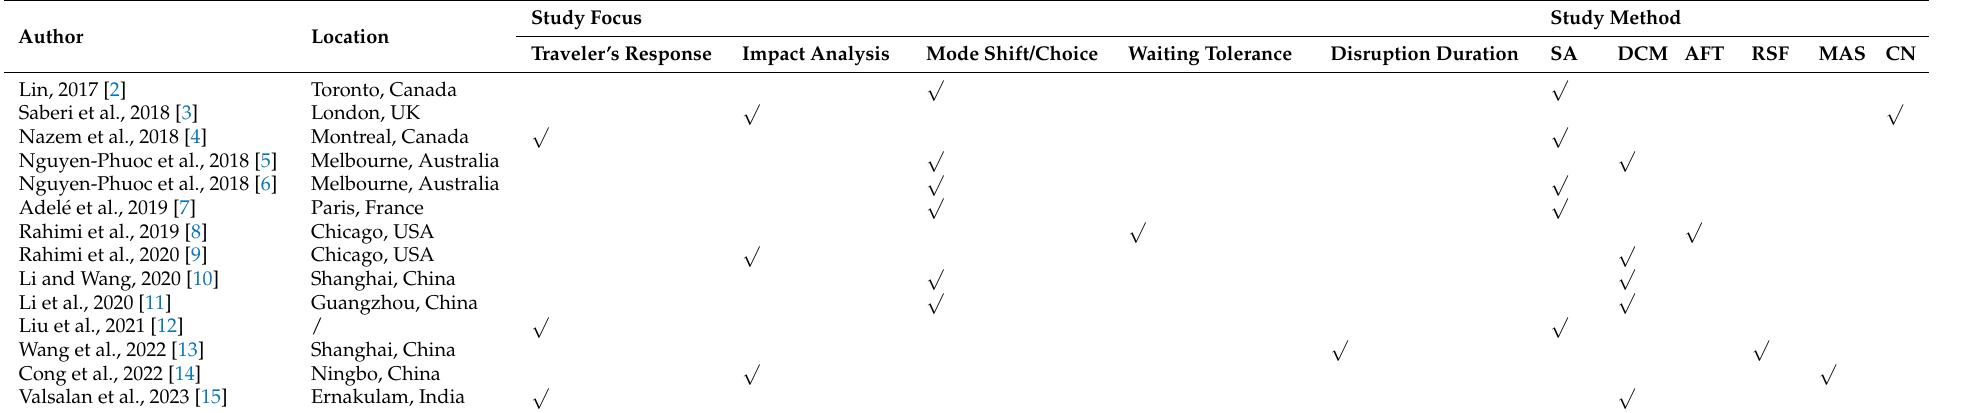
Table 1. Literature on the various aspects of URT service